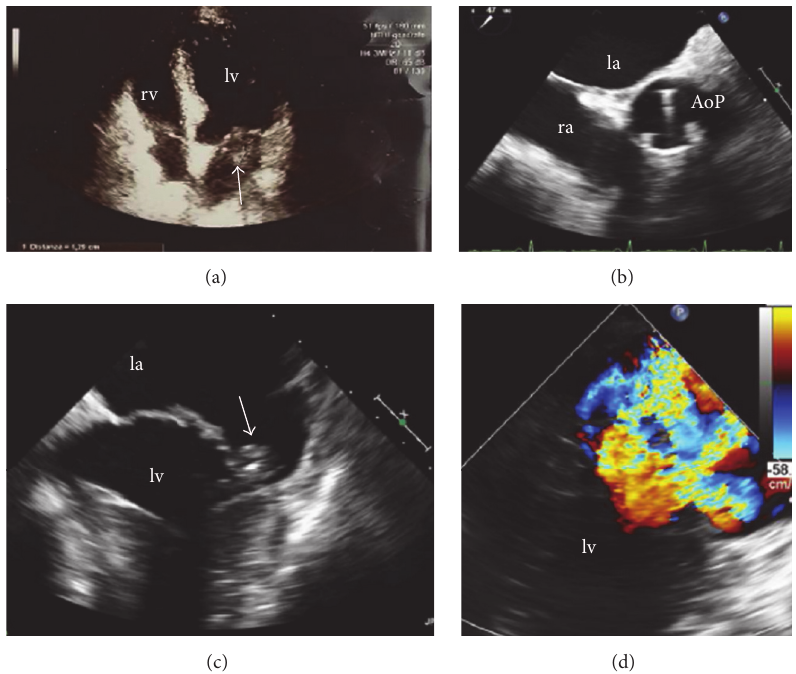
Figure 1: TTE 4-chamber views showing (a) a vegetation arising from the posterior leaflet of mitral valve. The vegetation was confirmed with TOE (c) that also documented a severe mitral regurgitation (d) and the prosthetic aortic valve (b). la: left atrium, lv: left ventricle, ra: right atrium, rv: right ventricle, and AoP: prosthetic aortic